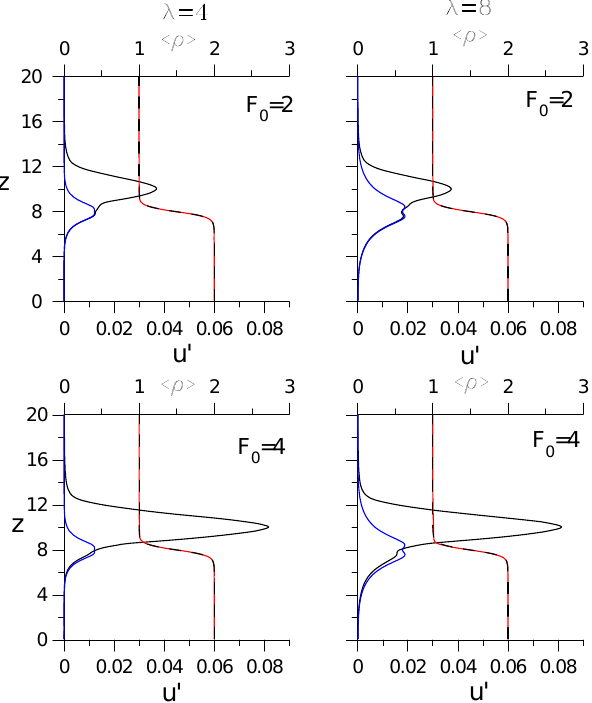
Fig. 7. Vertical profiles of the fluctuation velocity u 0 and mean density h /rho i (red line) obtained in DNS at t = 300 with turbulence forcing on and off (in black and blue line, respectively) and initially excited IW with wavelengths λ = 4 (left coloumn) and λ = 8 (right coloumn) for the forcing amplitudes F 0 = 2 (top) and F 0 = 4 (bottom). The reference (initial) density profile, ρ ref (z) , is shown in dashed line for comparison.